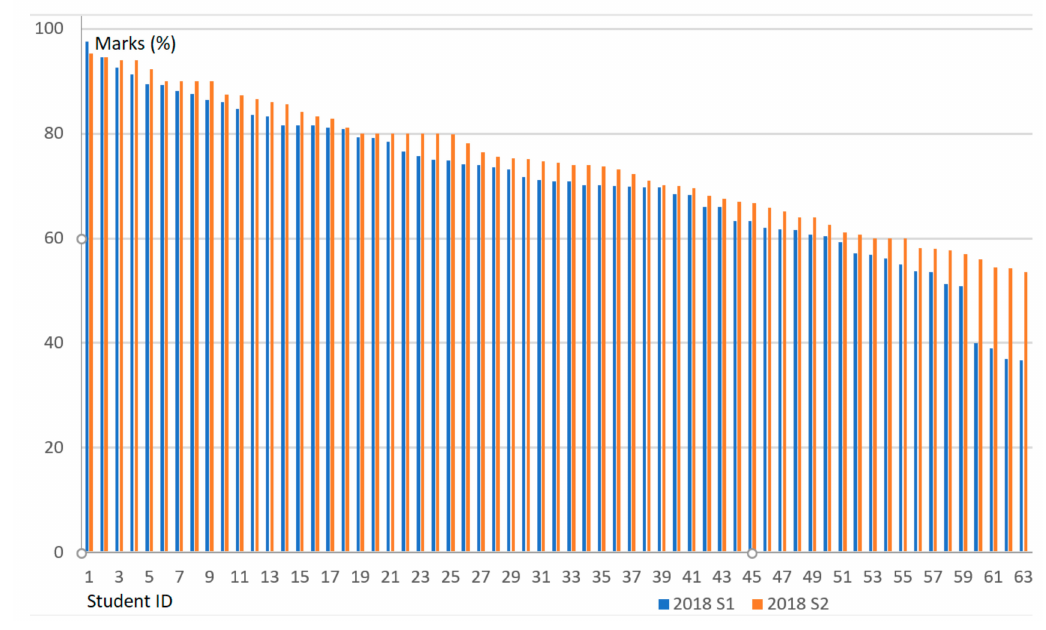
Figure 5. Comparison of student performance (S1 and S2).